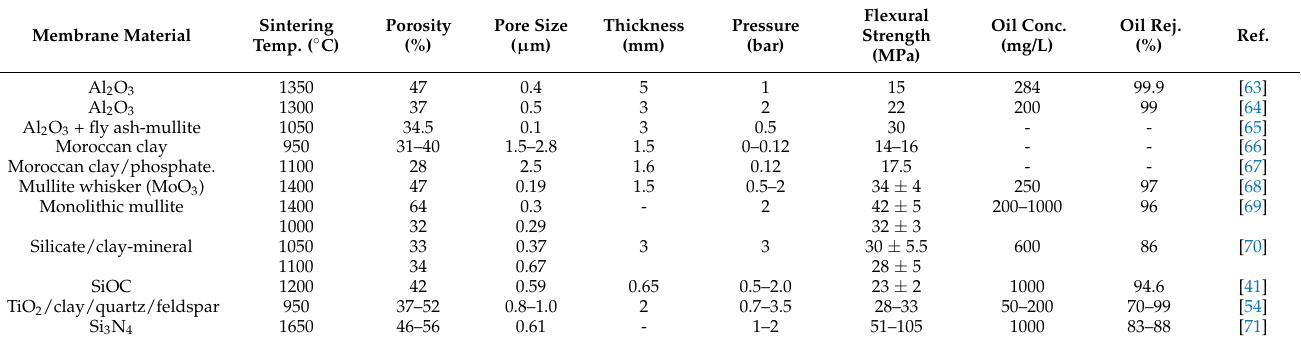
Table 2. Properties of planar ceramic membranes for microfiltration.